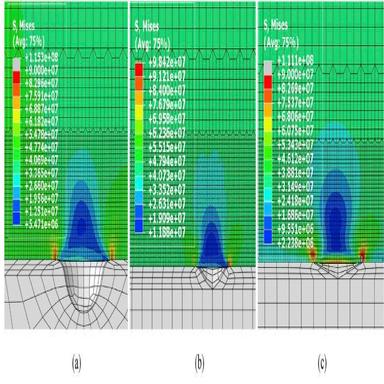
Steady-state stress distribution in PTFE composite sliding again steel surface with medium coverage (1.6%) of (a) Type A (wide & deep) dimples, (b) Type B (narrow & shallow) dimples and (c) Type C (wide & shallow) dimples.